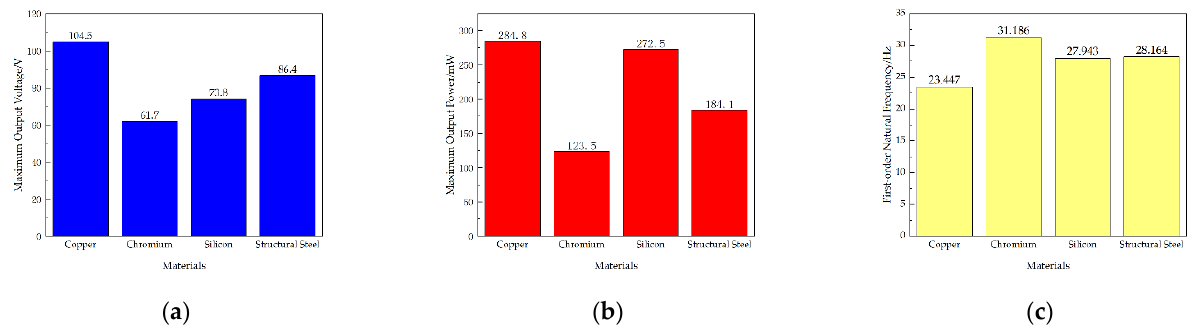
Figure 7. ( a ) Maximum output voltage of the STTM-PEH under different substrate materials. ( b ) Maximum output power of the STTM-PEH under different substrate materials. ( c ) First-order nat- ural frequencies of the STTM-PEH under different substrate